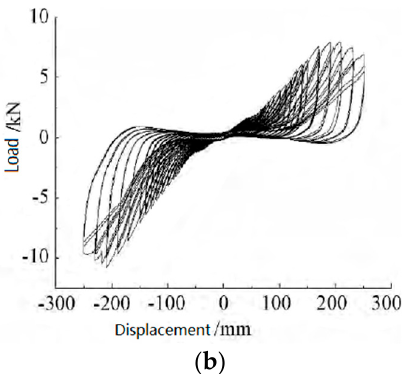
Figure 14. Figures from reference [29]: ( a ) Test model; ( b ) hysteretic curves.